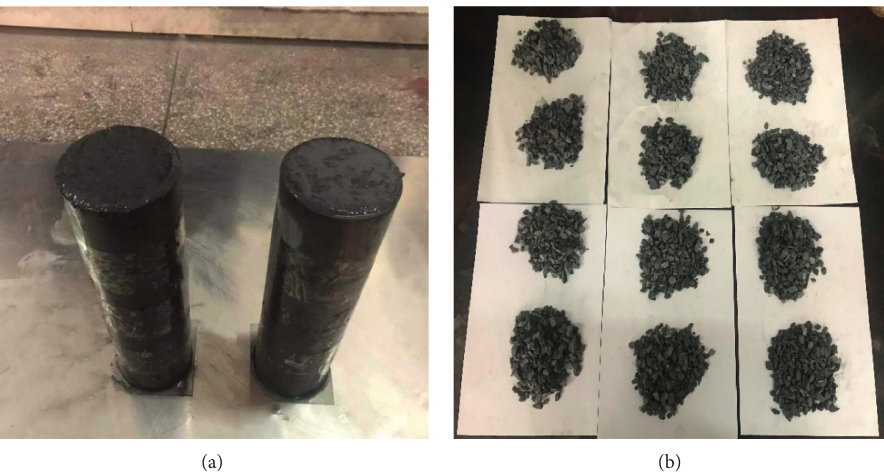
Figure 3: Graph of segregation rate test. (a) Measuring device. (b) Gangue particles with particle size greater than 5mm.